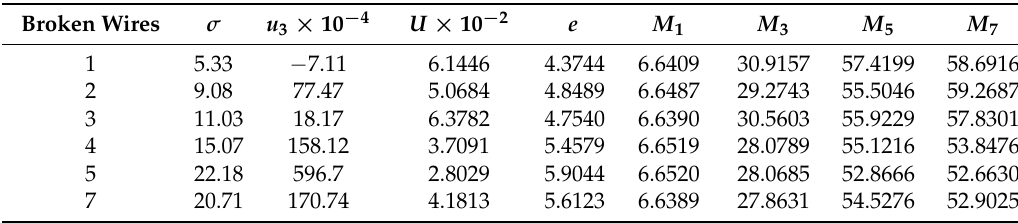
Table 2. Part defect sensitive characteristic